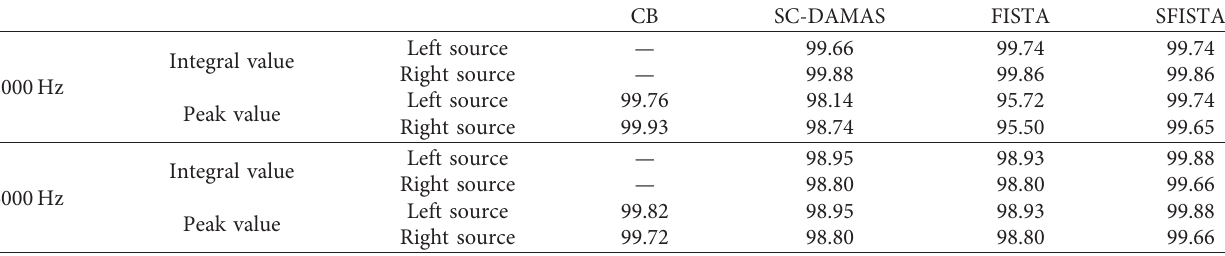
Table 1: Simulation quantification results using different